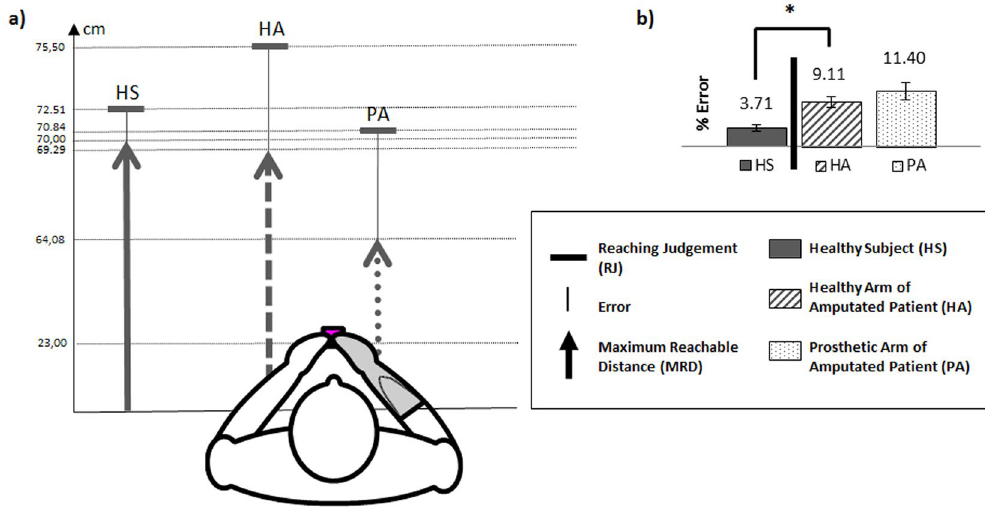
Figure 2. ( a ) MRD (arrow), RJ (perpendicular line) and error, in cm, in healthy subjects and the healthy and prosthetic arms of the patients. Values indicated are the mean obtained over groups and conditions. ( b ) Error of RJ as a % of the MRD, in healthy subjects and the healthy and prosthetic limbs of the